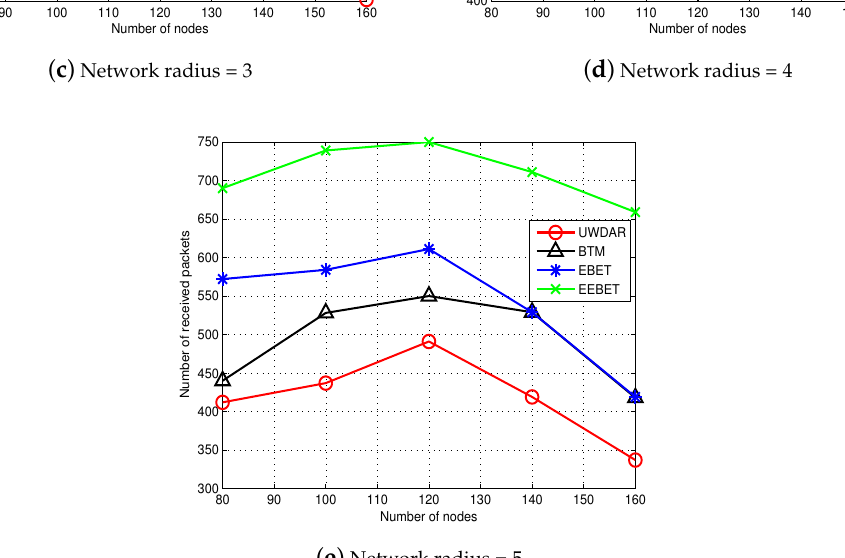
Figure 12. Impact of number of nodes and network radius on